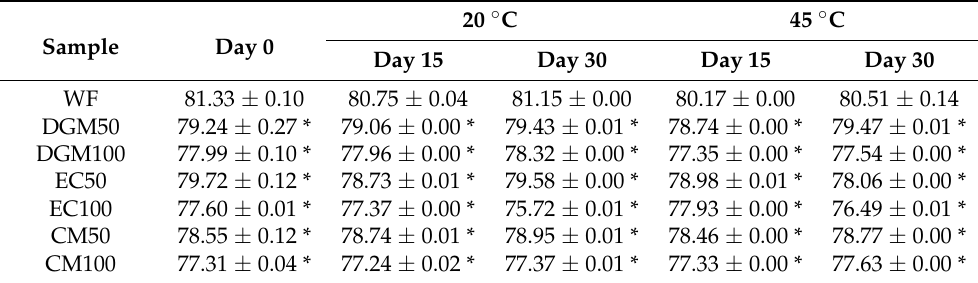
Table 6. Effect of addition of non-encapsulated (DGM), encapsulated (EC) and color-masked (CM) defatted Nannochloropsis oceanica to wheat flour (WF, control) on color coordinate L 1 .